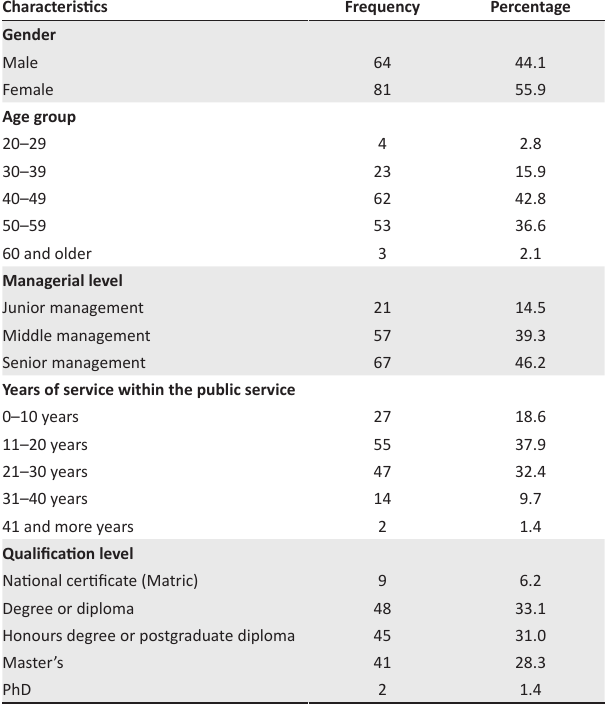
TABLE 2: Demographic characteristics of public sector managers.